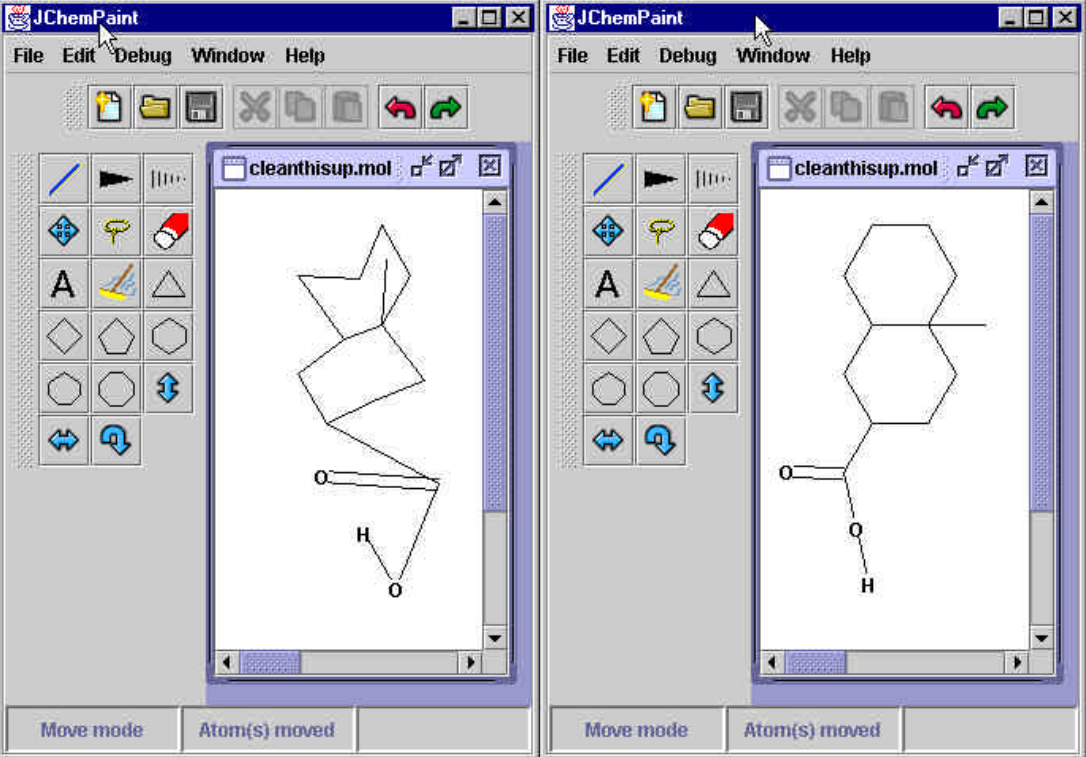
Figure 2. Before and after - the effect of a JMDraw clean